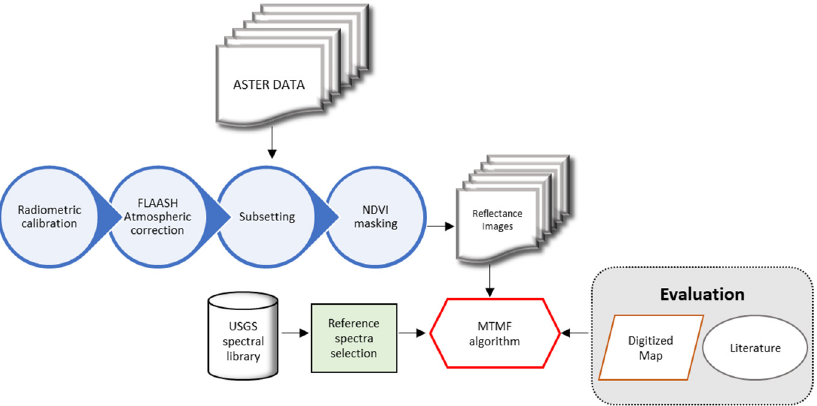
Figure 2. Flowchart summarising the methodology used in this study.